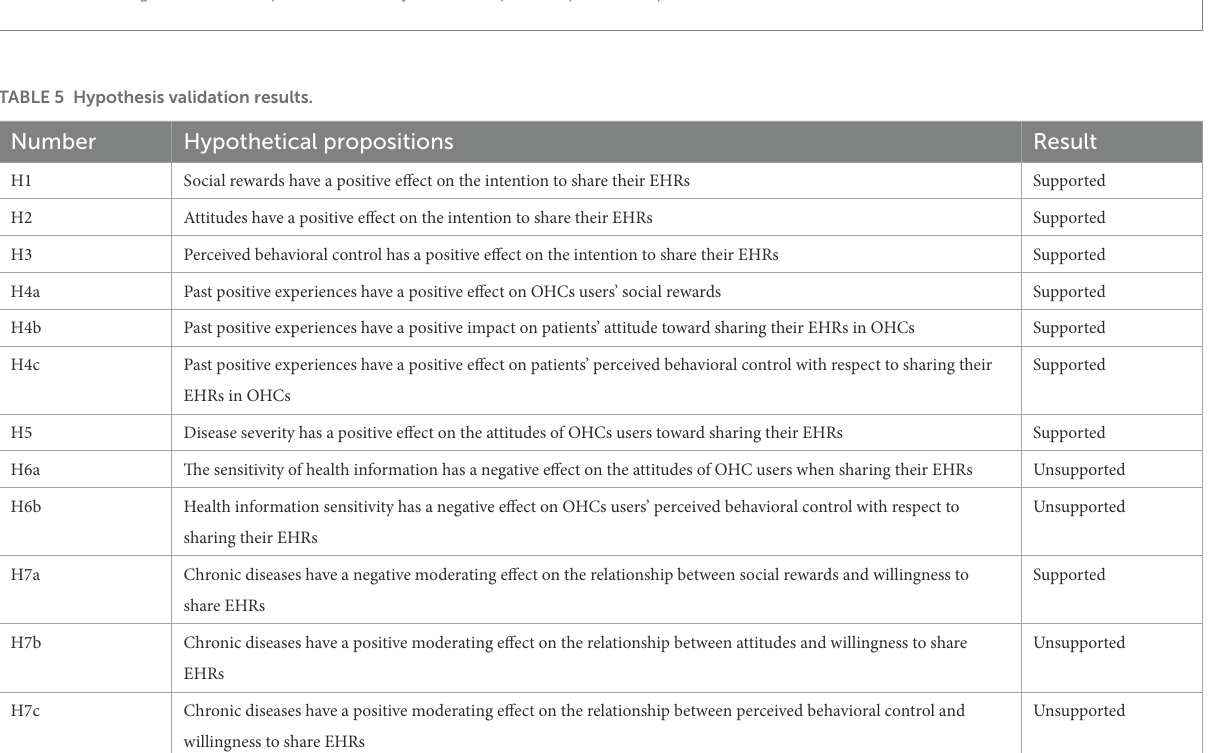
FIGURE 3 Schematic diagram of the complete model analysis results. * p < 0.1, ** p < 0.05, *** p <